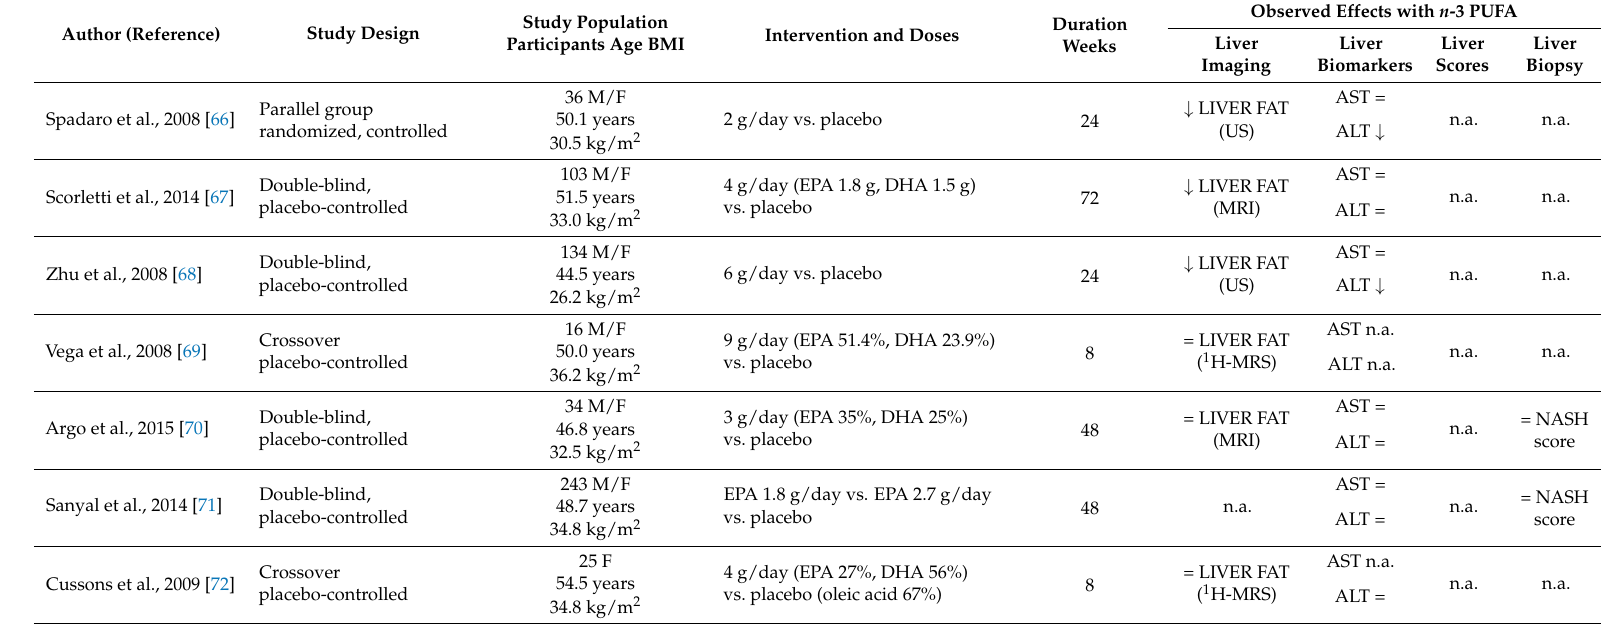
Table 2. Clinical trials on the effects of n -3 PUFA on NAFLD in individuals at high cardiometabolic